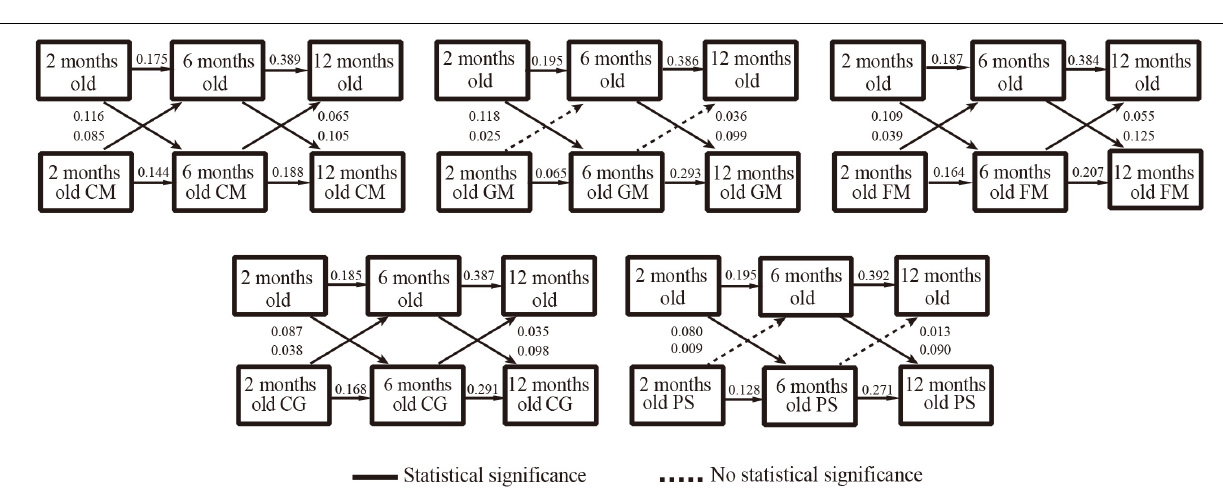
FIGURE 3 | Results of cross-lag analysis between opportunities for early learning and development of infants. CM, communication; GM, gross motor; FM, fine motor; CG, problem-solving; PS,